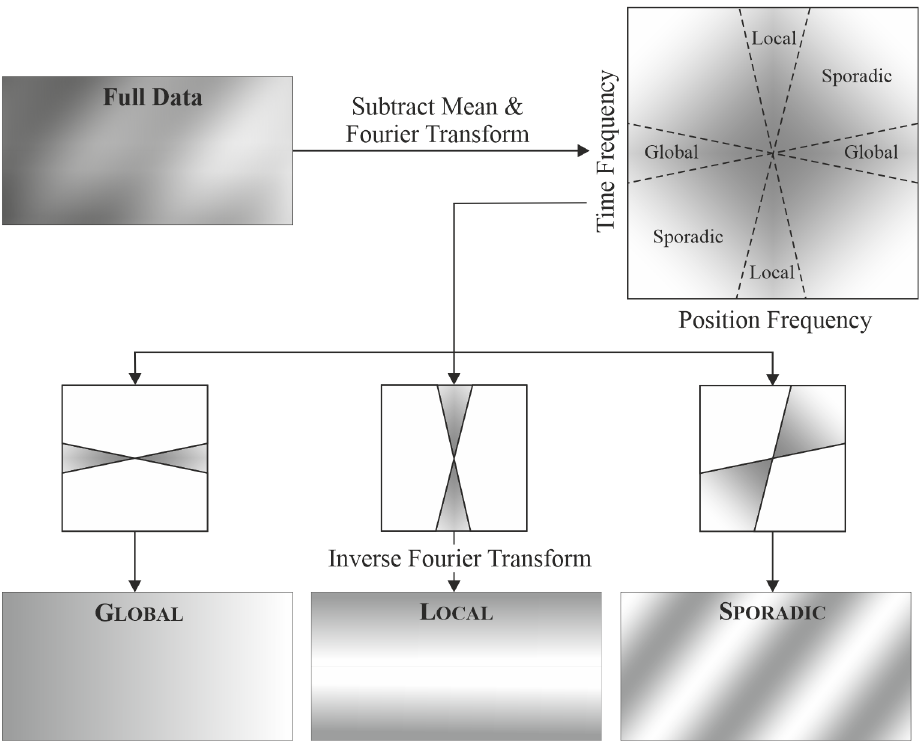
Figure 2. Steps for obtaining directionally filtered triboscopic images from the triboscopic data. From the filtered triboscopic data it is possible to gain a comparable and characteristic value indicating the magnitude in the specific direction by taking the mean of all points in the filtered data for both position and time. These values are called directional mean coefficient of friction and denoted as such: COF global , COF local , and COF sporadic